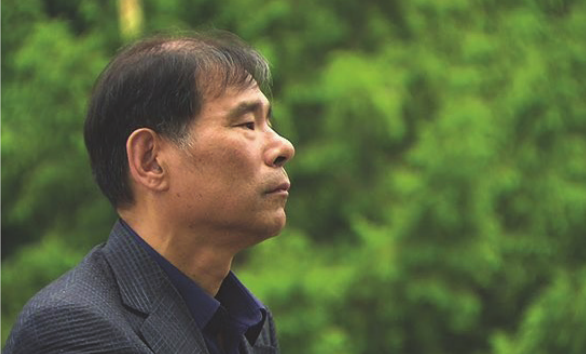
Figure 1. Picture of Dr. Hyun-Sul Lim in 2015 provided by his family.